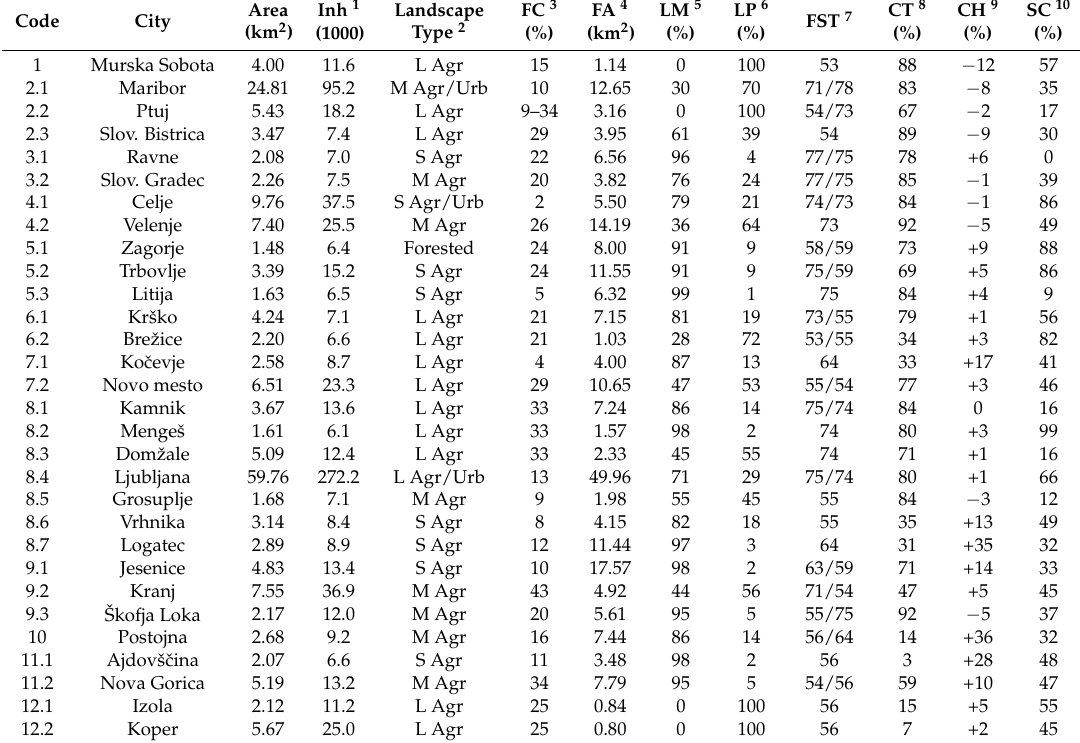
Table 2. Landscape indices and primeval structure of forests surrounding the largest Slovenian cities. Code City